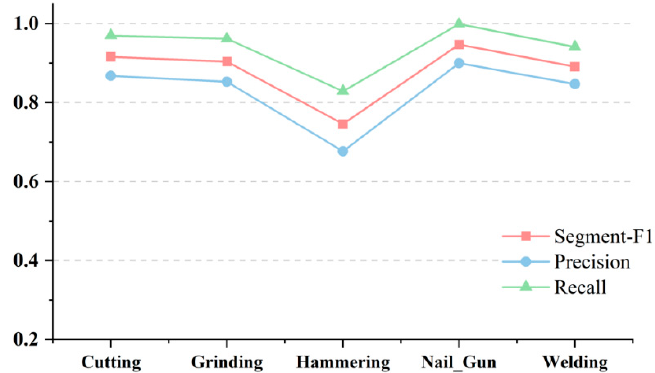
Figure 14. Results for Tagging F1, precision and recall.